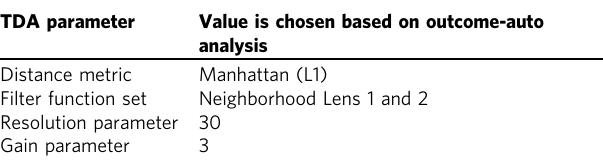
Table 1 TDA parameters revealed by a data-driven approach applied on the CMP